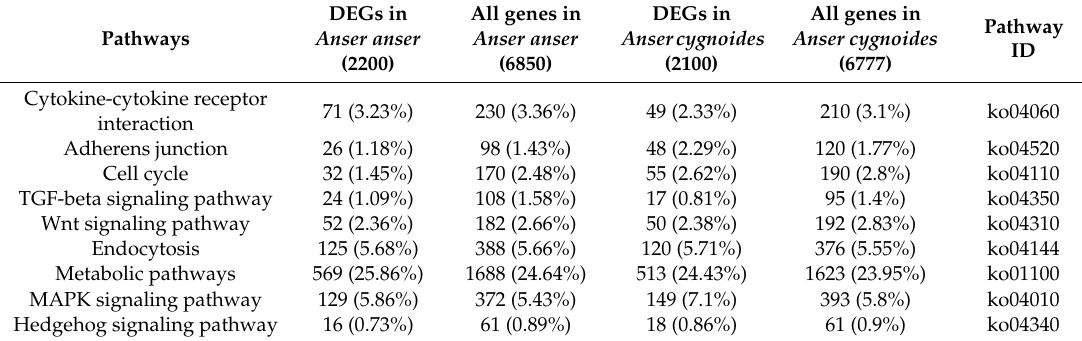
Table 2. Statistically common enriched GO terms (GO: 0001942 // hair follicle development; GO: 0043588 // skin development) between Anser anser and Anser cygnoides .